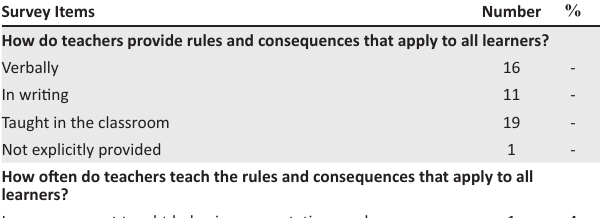
TABLE 1: Continuum of evidence-based interventions. Survey